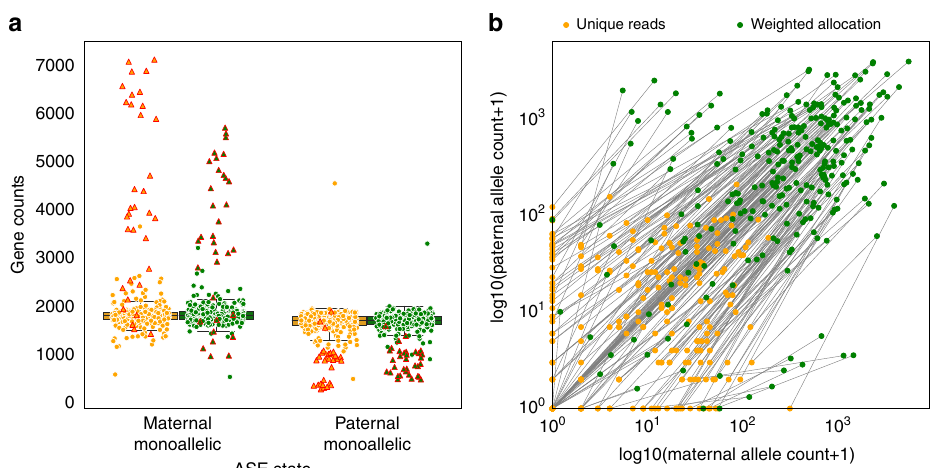
Fig. 2 Weighted allocation of multi-reads reduces monoallelic expression calls. a For each of 13,032 genes, we obtained the allele-speci fi c read counts by unique reads and by weighted allocation. We counted the numbers of genes in each cell that showed either maternal or paternal monoallelic expression. Each data point in this fi gure represent a cell. Yellow and green circles indicate unique-reads and weighted allocation respectively, for all 286 cells. The zygote and 2-cell stage cells (highlighted in red triangles) have large numbers of genes with maternal monoallelic expression. On average there are (cid:1) 66 fewer monoallelic calls per cell with the weighted allocation counts. The outlier cell with high levels of paternal monoallelic expression was noted in Deng et al. 8 b We selected one gene ( Mtdh ) to illustrate the distribution of maternal ( X -axis) and paternal ( Y -axis) counts across 286 cells. The weighted allocation counts (green) are connected to their corresponding unique counts by a line in the scatter plot